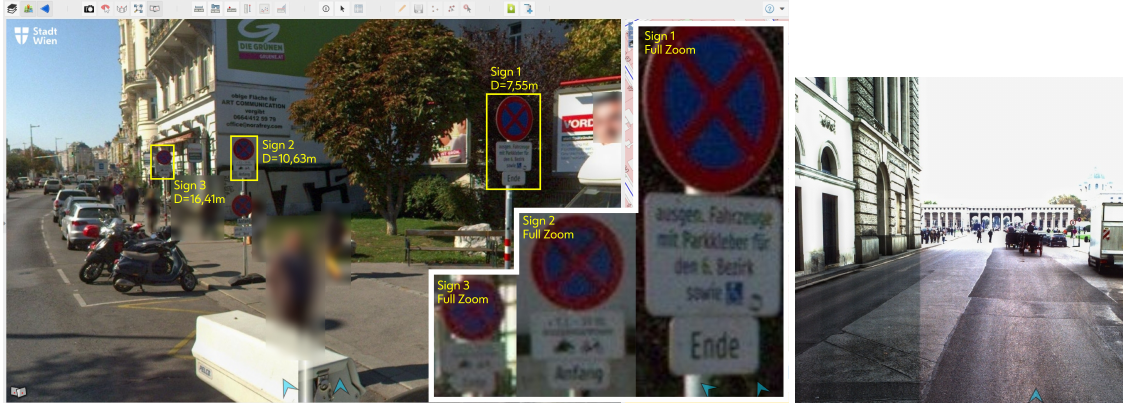
Figure 1. Examples of mobile mapping images with quality insufficient for assessment of the local situation, e.g., reading street signs at different distances, unmotivated changes in image brightness and too low dynamic